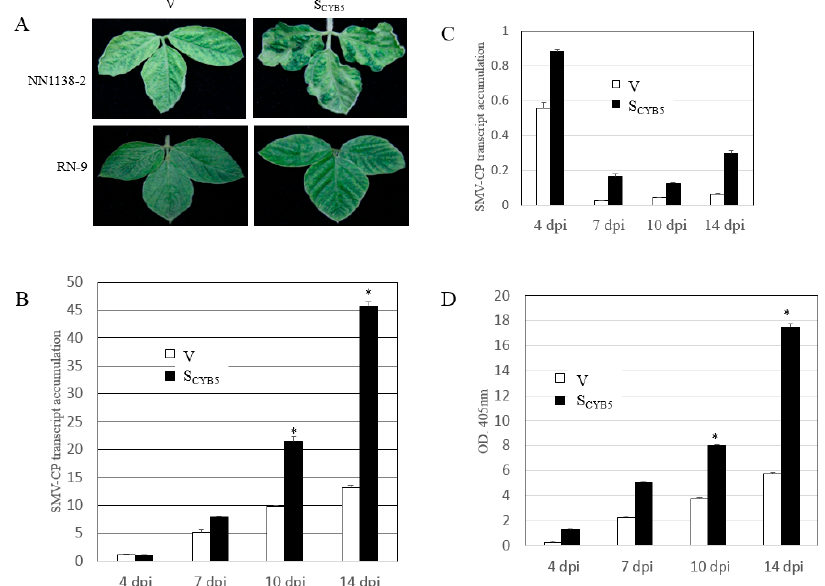
Figure 5. Silencing GmCYB5 alters soybean response to SMV. ( A ) Visual symptoms of SMV-SC15 on GmCYB5- silenced plant (S CYB5 ) (right panels), control plant inoculated with BPMV vector (V) (left panels), and susceptible plant (NN1138-2) (upper panels) and resistant plants (RN-9) (lower panels). ( B ) qRT-PCR analysis of SMV coat protein (CP) level at indicated dpi in V and S CYB5 plants of susceptible cultivar (NN1138-2) and ( C ) resistant cultivar (RN-9). Error bars indicate SD ( n = 3). Asterisks denote significant differences from V for each time point, t -test, p < 0.001. Results are representative of two to three independent experiments. ( D ) ELISA results of SMV CP level in V and S CYB5 plants (cv. NN1138-2) inoculated with SMV-SC15 at indicated dpi (4, 7 dpi from I, 10 and 14 dpi from S) with SMV SC15. Error bars indicate SD ( n = 3). Asterisks denote significant difference from V, t -test, p < 0.001. Results are representative of three independent experiments.